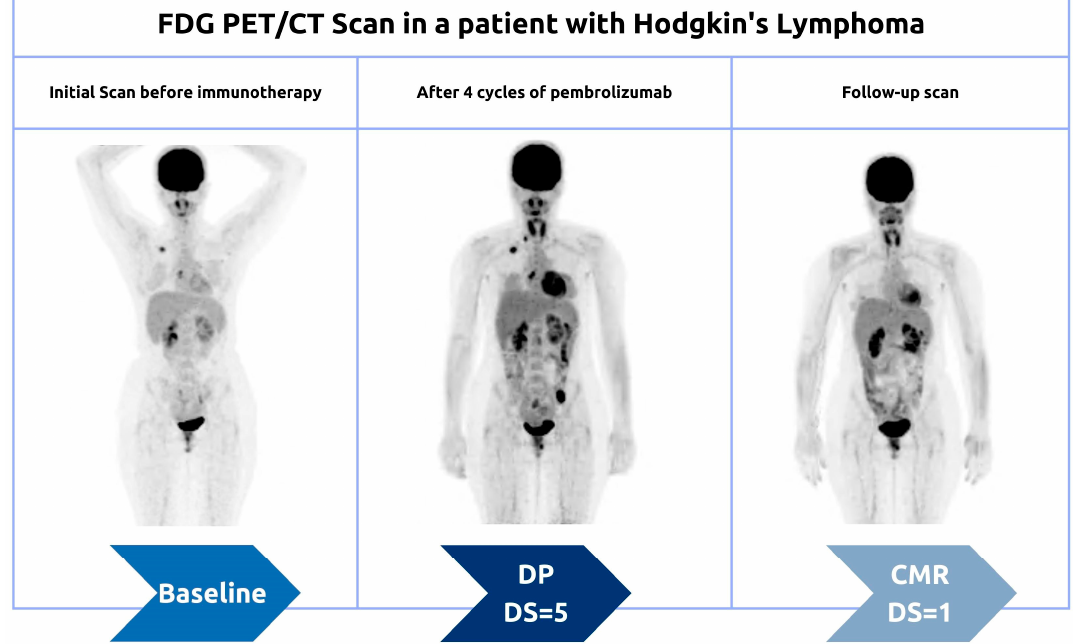
Figure 3. Serial Maximum Intensity Projection (MIP) images of an HL patient demonstrating pseudoprogression pattern during the interim period.